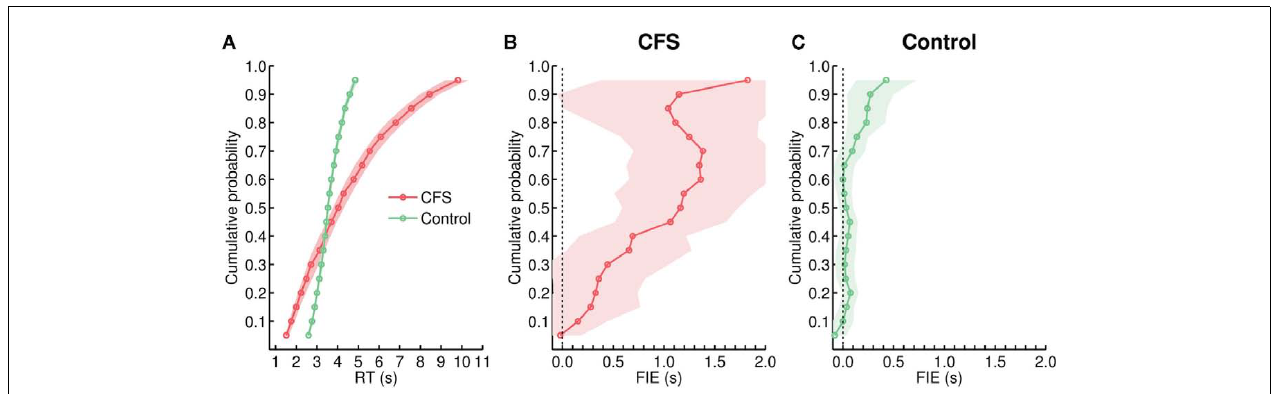
FIGURE 10 | (A) Cumulative group distributions of RTs from the CFS and from the 8.5-s ramp control condition in Experiment 4. (B,C) Size of the FIE as a function of percentiles, plotted separately for the CFS and the 8.5-s ramp control condition.